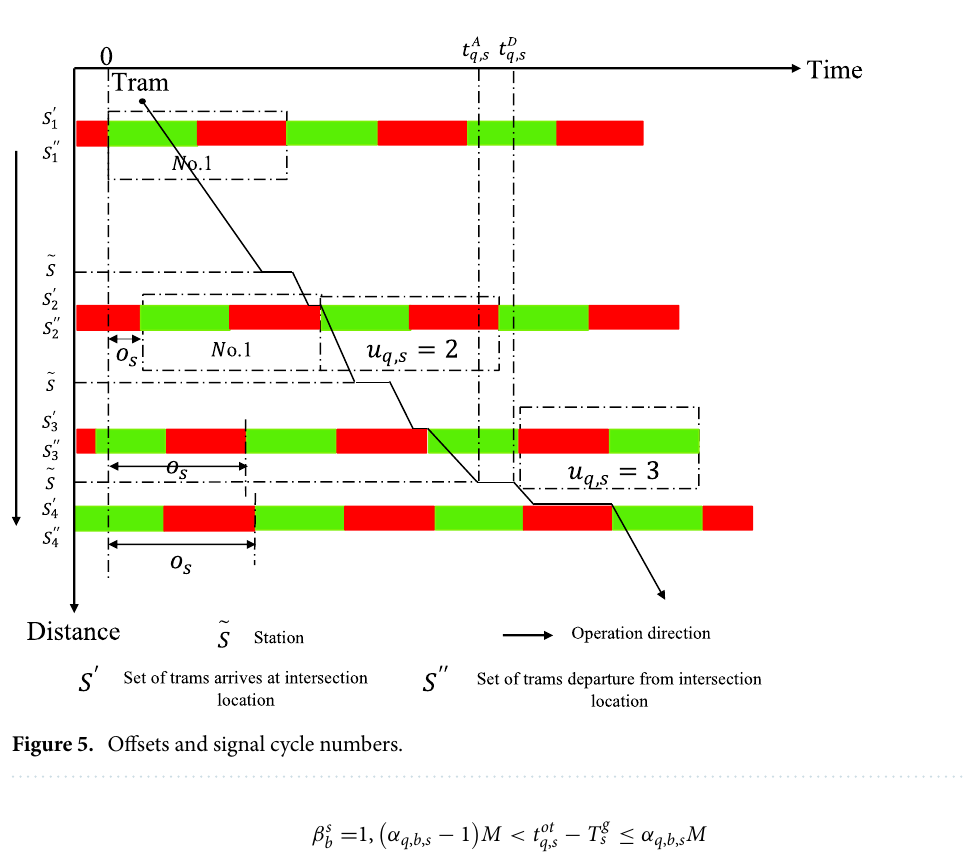
Figure 5. Offsets and signal cycle